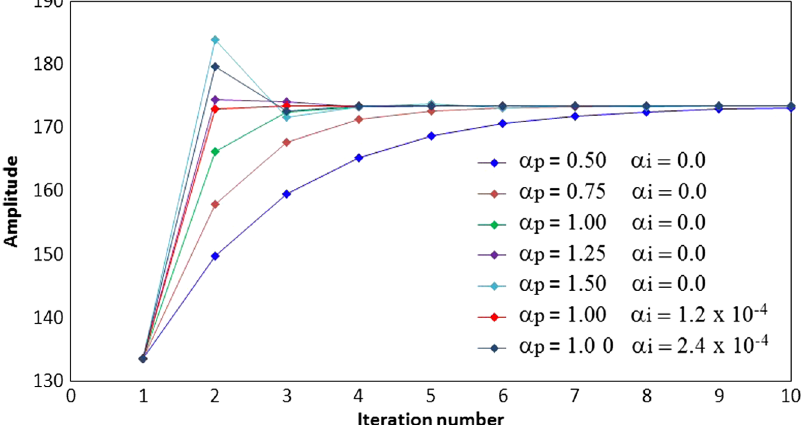
FIG. 6. Convergence of pulse amplitude as a function iteration number at time 266 ns after the phase flip for differing controller coefficients.